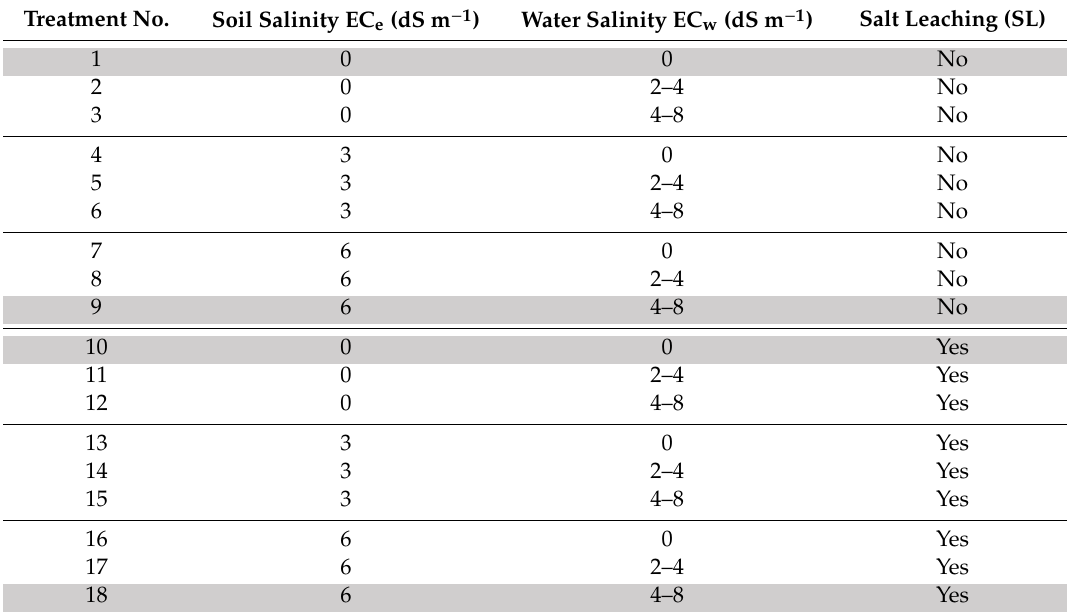
Table 1. Scheme of the 18 treatments obtained by combining three levels of soil salinity (EC e ), three levels of water salinity (EC w ), and two water regimes (SL). Shaded rows indicate the four corner treatments whose data are discussed in this paper. Treatment